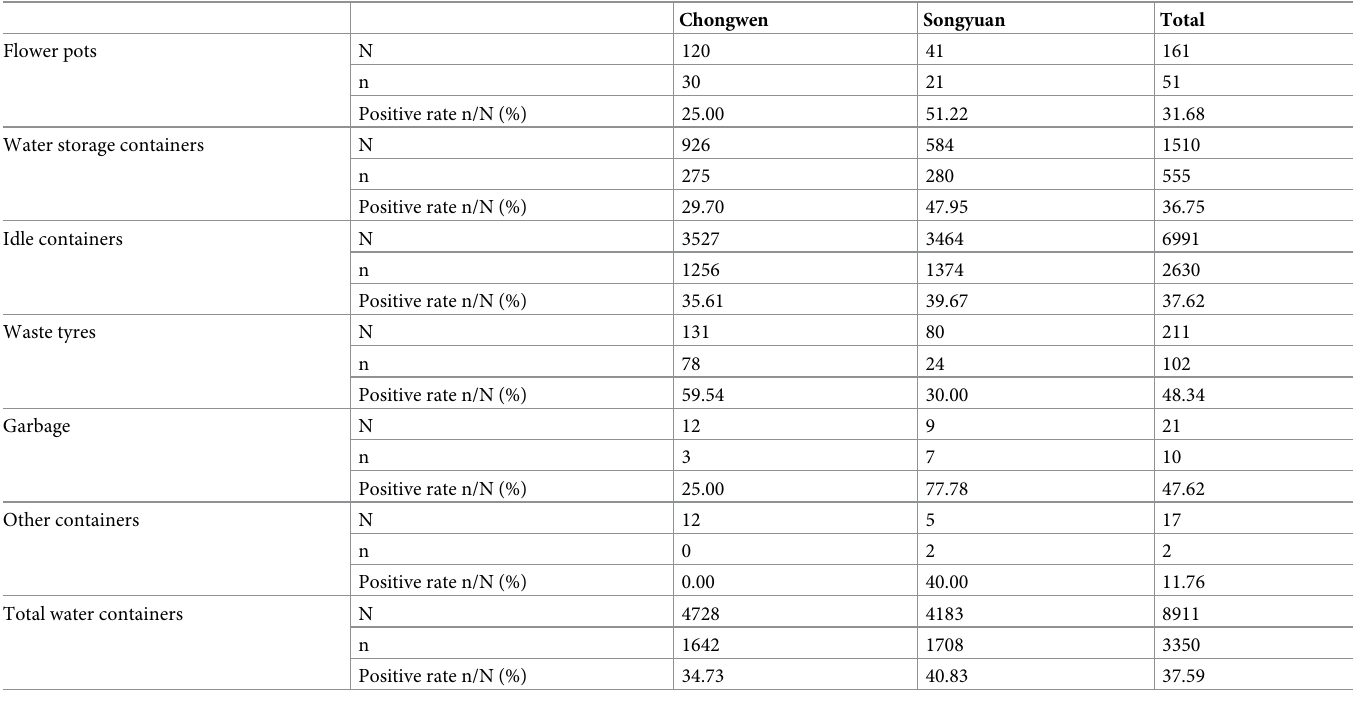
Table 1. Water containers inspected in Chongwen and Songyuan